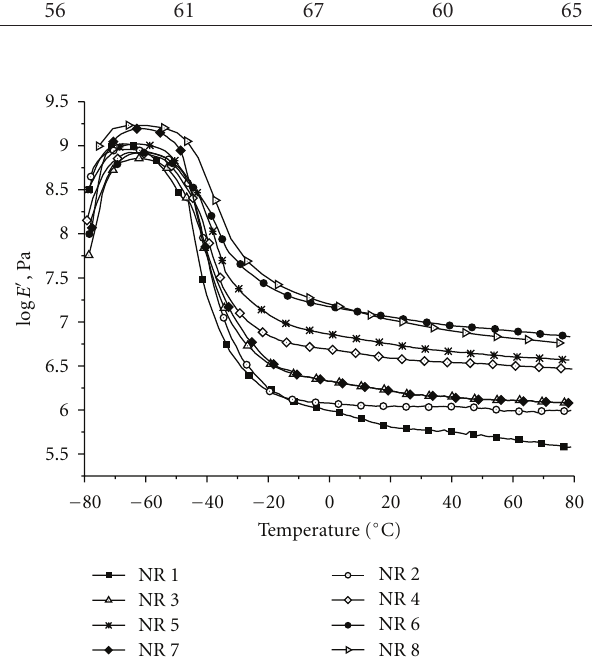
Figure 1: Temperature dependence of the storage modulus (E (cid:3) ) for composites comprising di ff erent amounts of Printex XE-2B or Corax